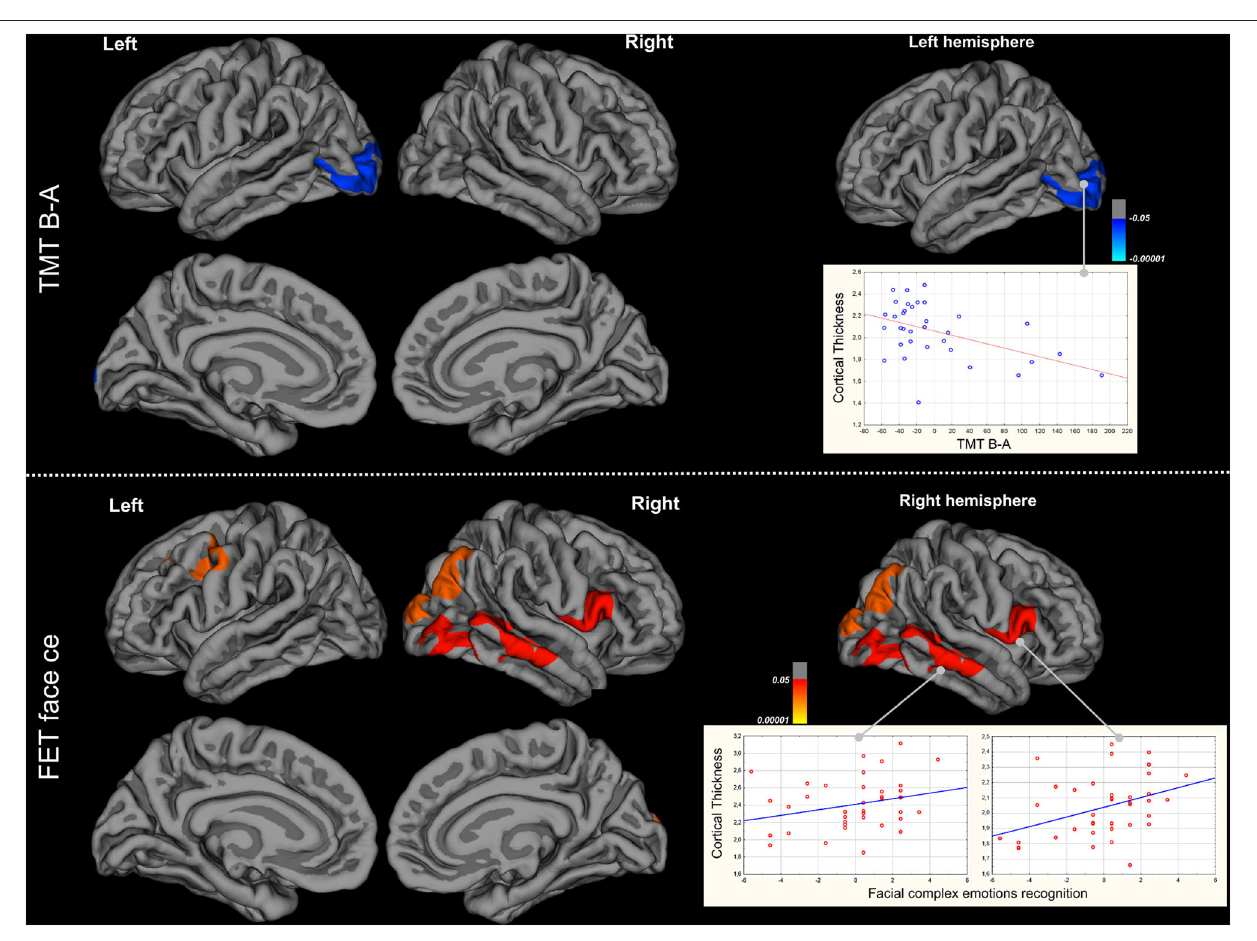
FIGURE 2 | Correlations at baseline between cortical thickness and TMT B-A and recognition of complex facial